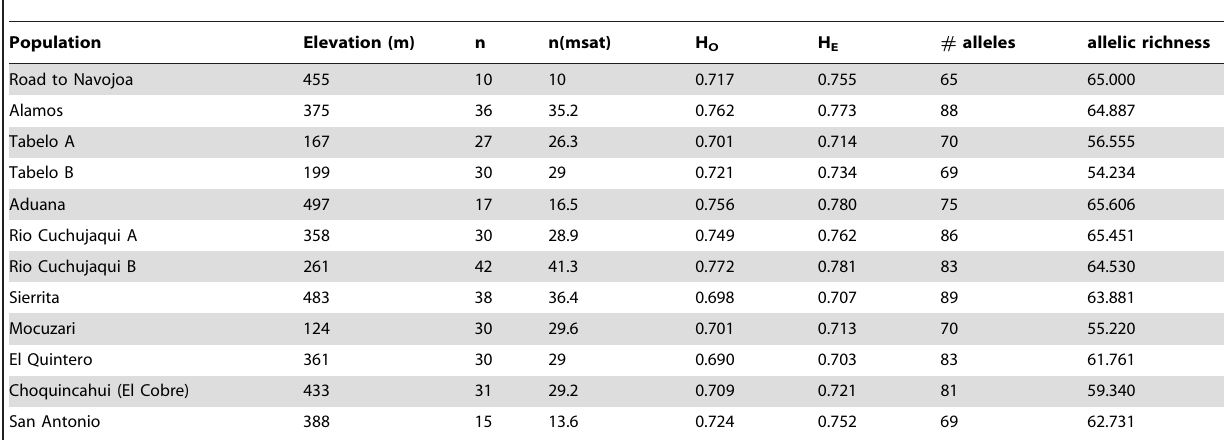
Table 1. Characterization of genetic diversity of Phyllodactylus tuberculosus at each sampling site included in this study based on data from 10 microsatellite